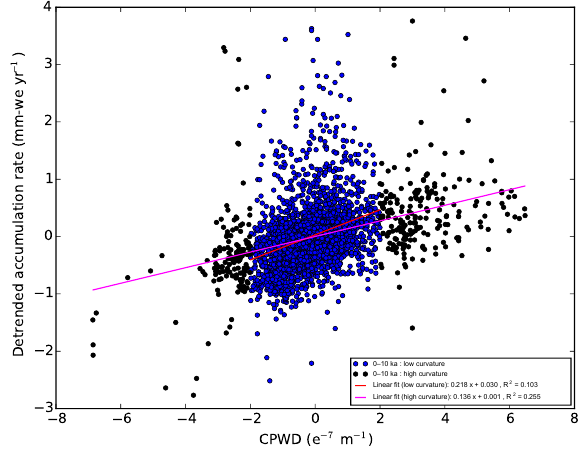
Figure 7. Relationship between CPWD and detrended accumula- tion rates for the youngest layer (0–10ka). Magenta and red lines are linear best fits for regions of high ( > 2 × 10 − 7 or < − 2 × 10 − 7 ) and low (between − 2 × 10 − 7 and 2 × 10 − 7 ) CPWD magnitudes, respectively. The correlation coefficient is higher for regions of high CPWD